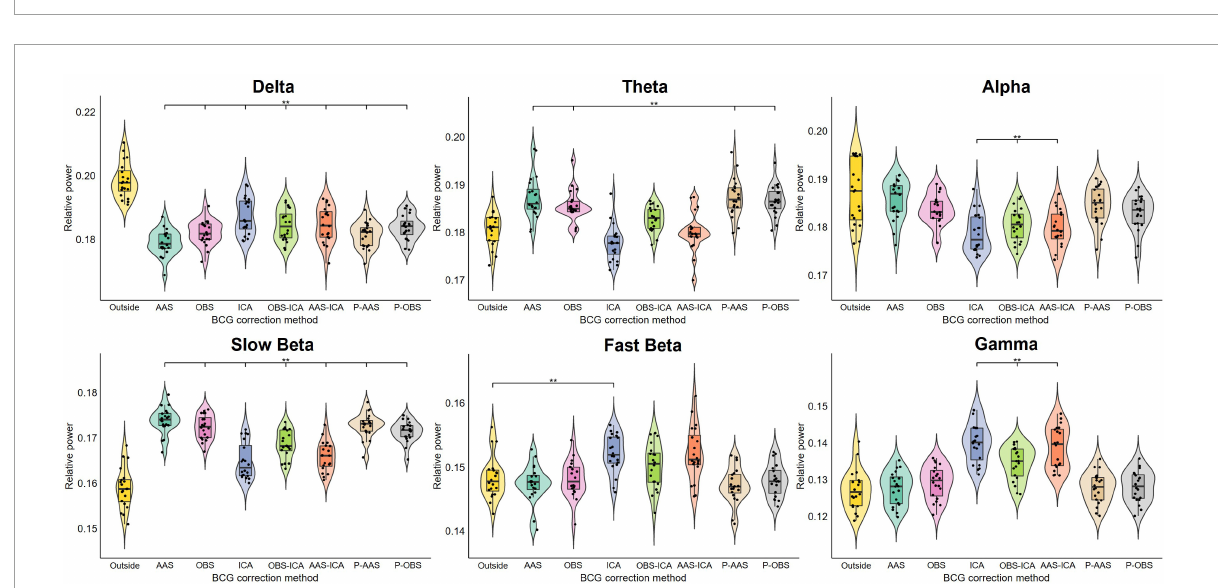
FIGURE4 Results of the repeated measures ANOVAs comparing the average relative power of all electrodes from all subjects between the Outside rs-EEG and the rs-EEG-fMRI data corrected using each of the seven BCG correction methods. Each frequency band was analyzed separately. The asterisks indicate significant statistical differences ( p adj < 0.05) between the corrected rs-EEG-fMRI and the Outside rs-EEG data. Relative power was altered across all frequency bands for the data recorded simultaneously with fMRI. Some correction approaches rescued relative power for some frequency bands, but the overall spectral power profile remained altered across all BCG correction methods. Note that PROJIC-AAS and PROJIC-OBS were abbreviated as P-AAS and P-OBS, respectively.